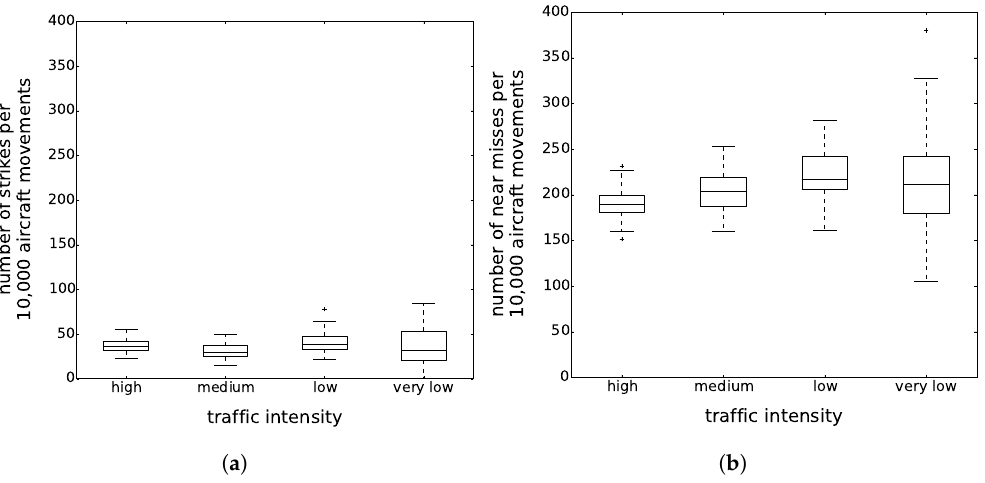
Figure 5. Boxplot values for the number of bird strikes over all Monte Carlo replications and for all traffic volumes. ( a ) Collisions; ( b ) Near